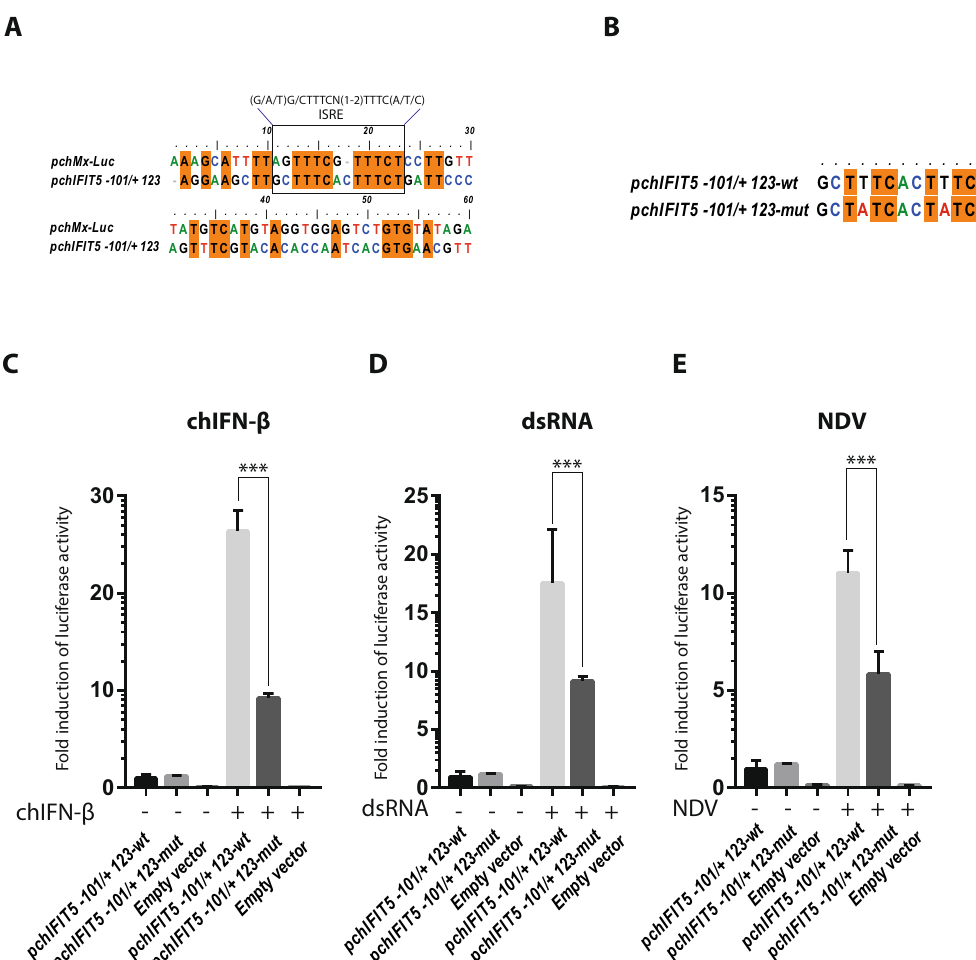
Figure 4. Identification and validation of functionally crucial motifs in chIFIT5 promoter immediately distal to the putative transcriptional start site. ( A ) Comparison of chMx and chIFIT5 responsive promoters, indicating a highly conserved ISRE element, which is composed of two triple-thymidines (TTT) motifs, which are separated by a single or double nucleotides in chMx and chIFIT5 promoters, respectively. ( B ) Mutagenesis of two triple thymidines motifs (TTT) to TAT in order to disrupt the core element are shown. ( C – E ) DF-1 cells were transfected with 150 ng of pchIFIT5–101/ + 123-wt, pchIFIT5–101/ + 123-mut promoter constructs or empty vectors along with 50 ng of pRenilla luciferase encoding loading control for 24 hours and were left unstimulated ( − ) or were stimulated ( + ) with 1000 U/ml of chIFN- β ( C ), 5 ug/mL of dsRNA ( D ) or 1 MOI of NDV (E) for another 24 hours before measuring the luciferase activities. Fold induction of firefly luciferase activities were measured and normalized to renilla luciferase and average data of three independent experiment is